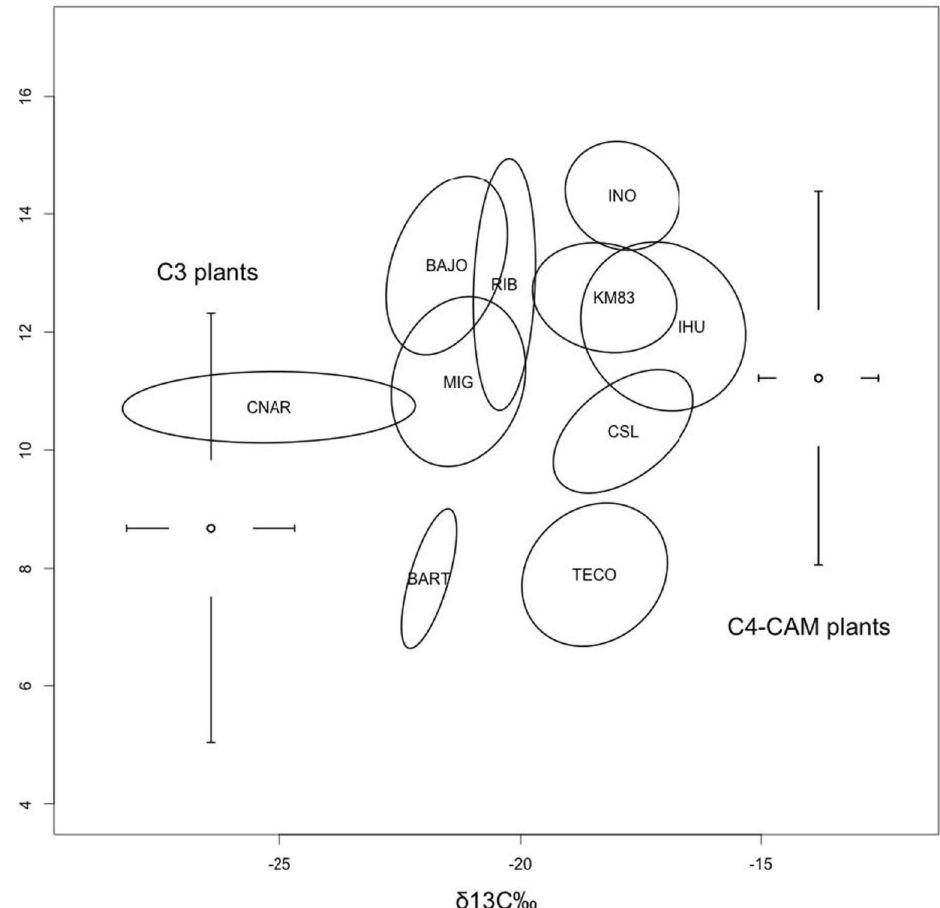
Fig 2. Stable isotope standard ellipses of whiptails for each of ten studied localities in southern Baja California (Mexico). Ranges and mean values of δ 15 N and δ 13 C of C 3 y C 4 -CAM plants sampled in the whole area are also shown. Localities are named according to Table